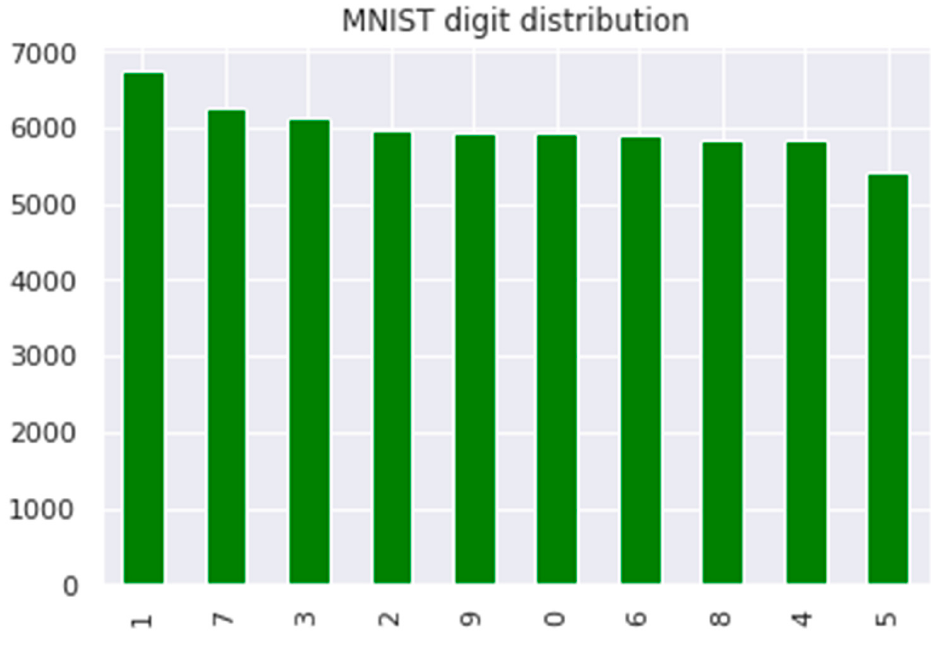
Figure 3. Total distribution of MNIST digits